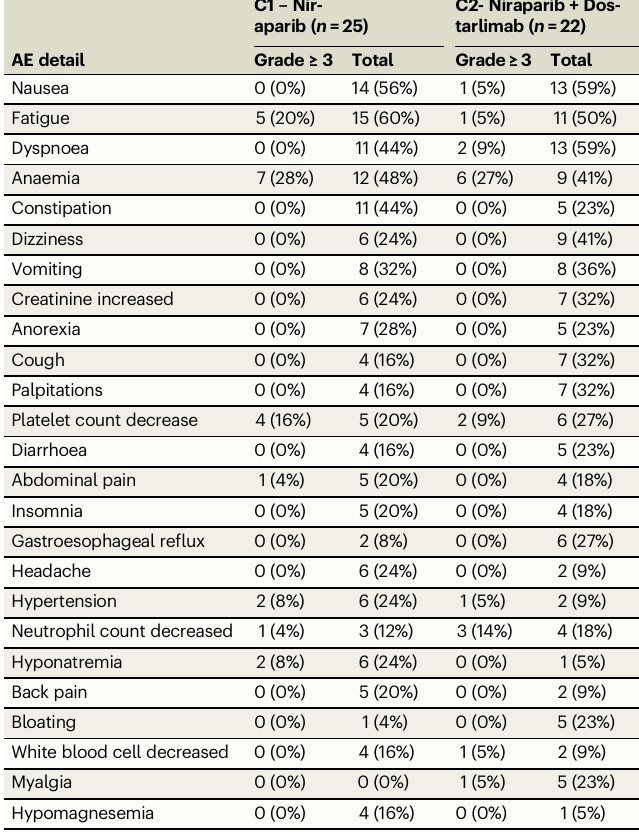
Table 2 | Adverse events occurring in ≥ 15% of patients in any treatment